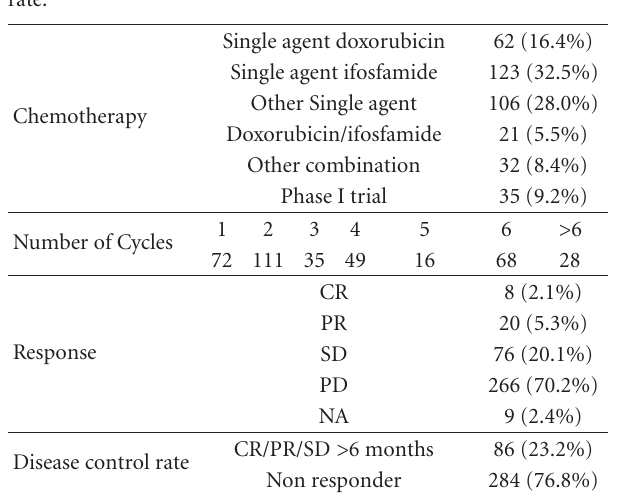
Table 2: Second-line chemotherapy regimens and disease control rate.